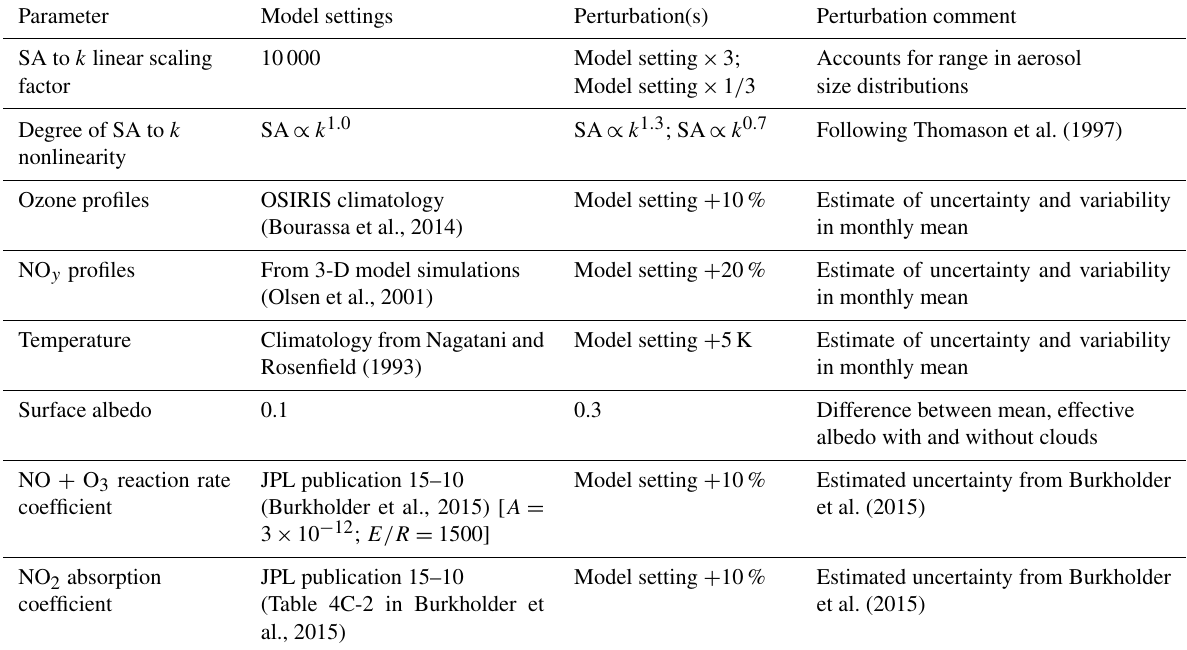
Table 1. Parameters considered for model perturbation